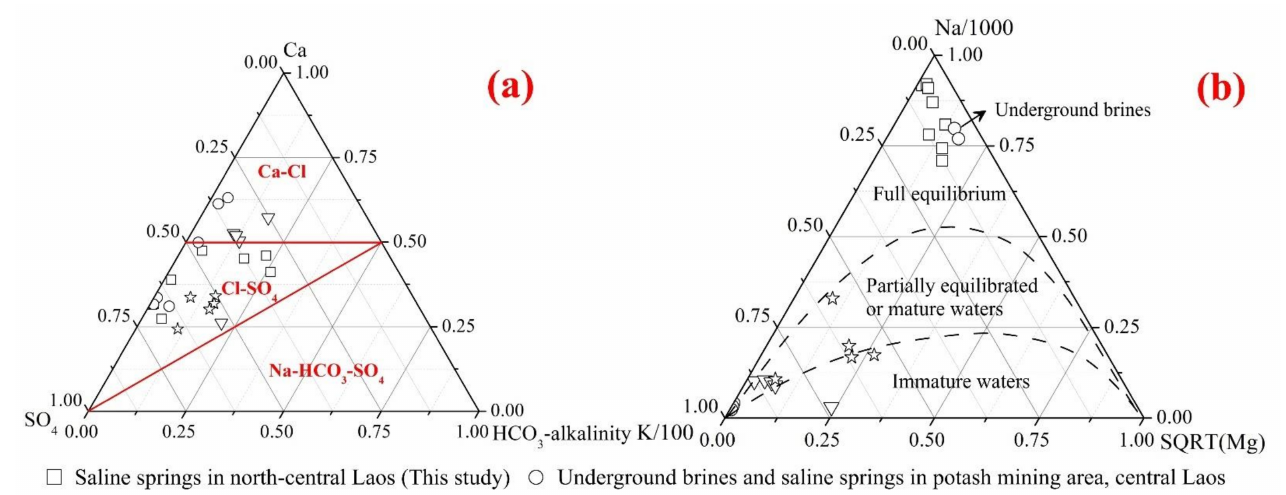
Figure 6. ( a ). Ternary Ca–SO 4 –HCO 3 phase diagram of saline springs from north and central Laos; ( b ). Na–K–Mg ternary diagram showing saline springs from north and central Laos. Date from